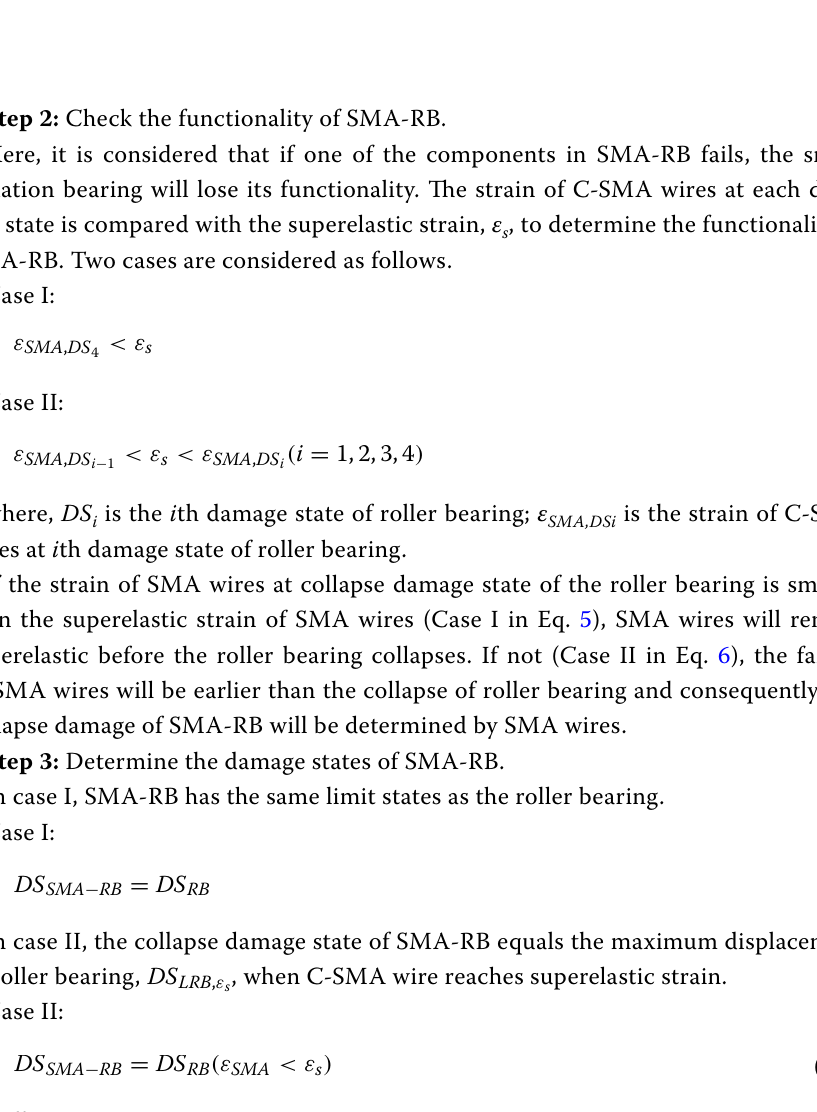
Table 1 Damage states of each vulnerable component Bridge EDP Limit States Reference Component Slight Moderate Extensive Collapse Cable ε / ε y 0.45 0.60 0.75 0.90 Zhong et al. 2017 Pier μ d 1.00 1.20 1.76 4.76 Hwang et al., 2001 Tower θ 0.007 0.015 0.025 0.050 Pang et al. 2013 Roller bearing Δ (mm) 120 180 240 300